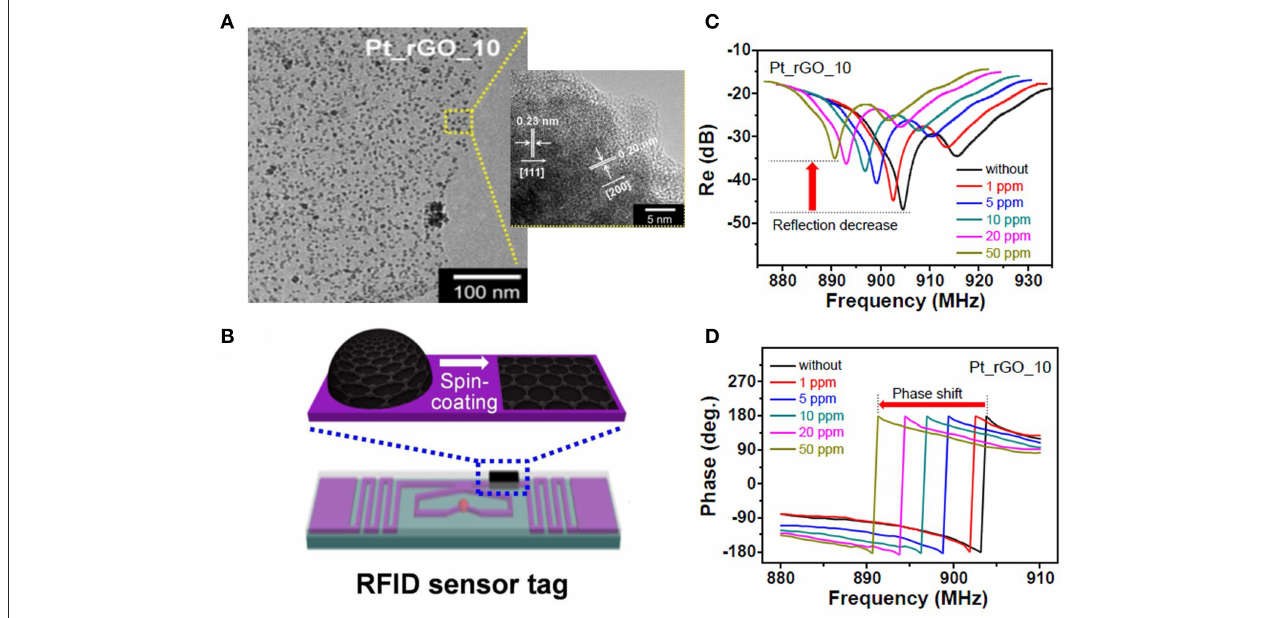
FIGURE 7 | (A) Transmission electron microscopy images of Pt-decorated reduced graphene oxide (Pt_rGO), (B) Pt_rGO-immobilized radio-frequency identification sensor tag, (C,D) change in the reflectance properties and measured reflection phase of different Pt_rGO-based wireless sensors as a function of the hydrogen gas concentration. Reproduced with permission from Lee et al. (2015). Copyright 2015 American Chemical Society.